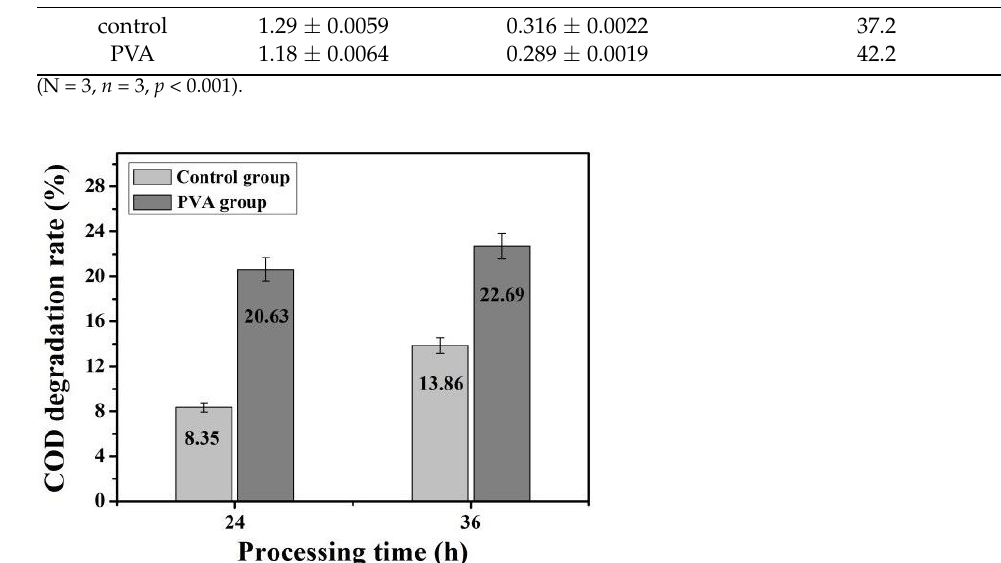
Figure 4. The degradation of microspheres-immobilized Bacillus velezensis strain treating 20% con- centration slaughter wastewater. Table 4. Protein degradation